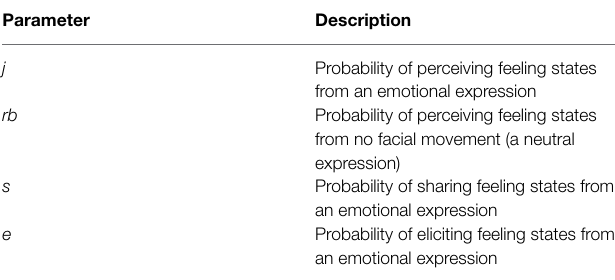
TABLE 1 | Psychological interpretation of the model parameters. Parameter